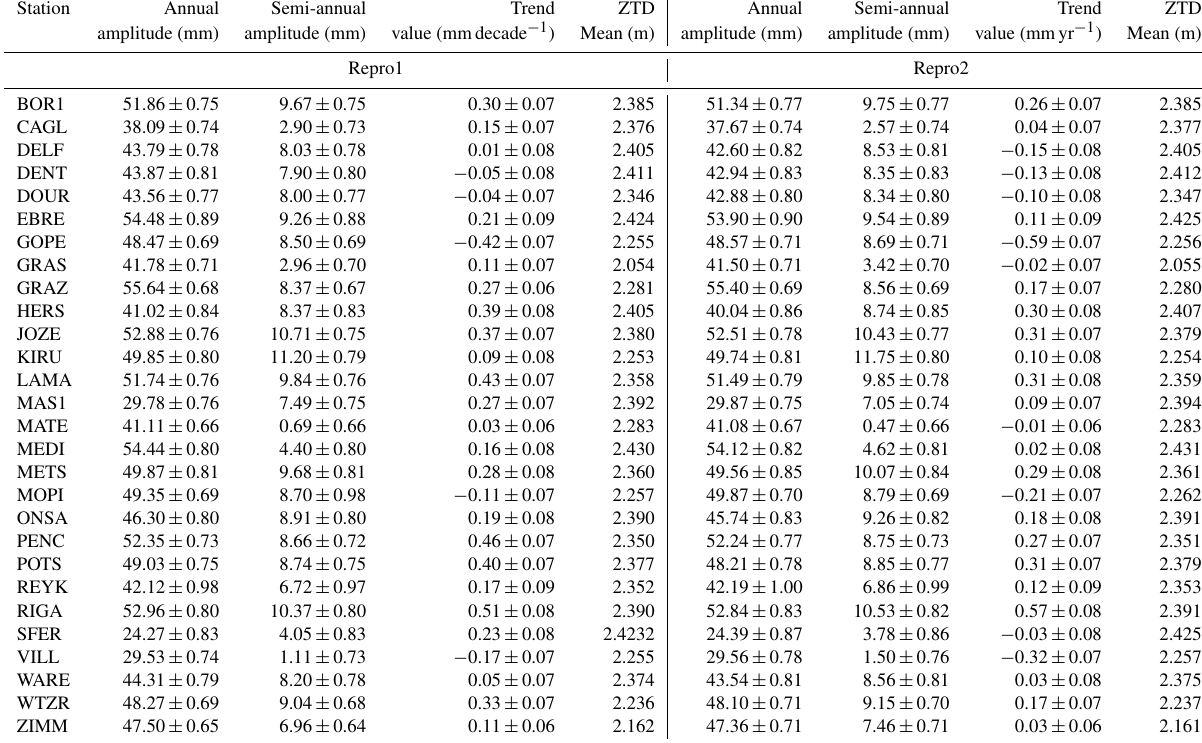
Table A2. Results of analysis of the 18-year ZTD time series from the first (Repro1) and the second (Repro2) EPN reprocessing campaigns.